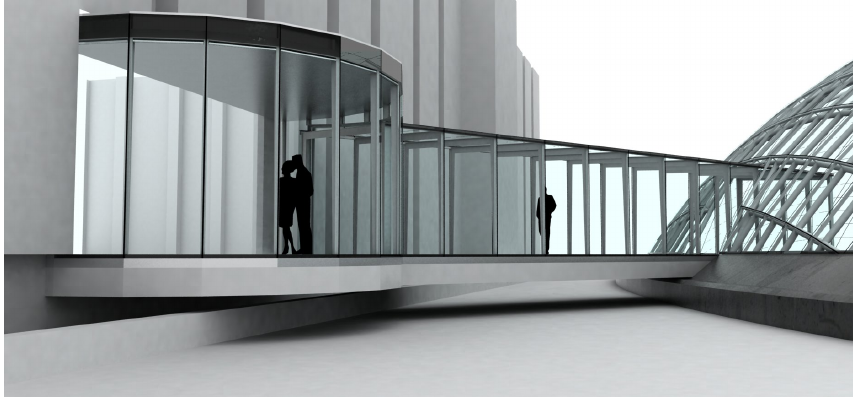
Figure 6: View of the bridge and the “knuckle” (© Glasbau Seele, Gersthofen).